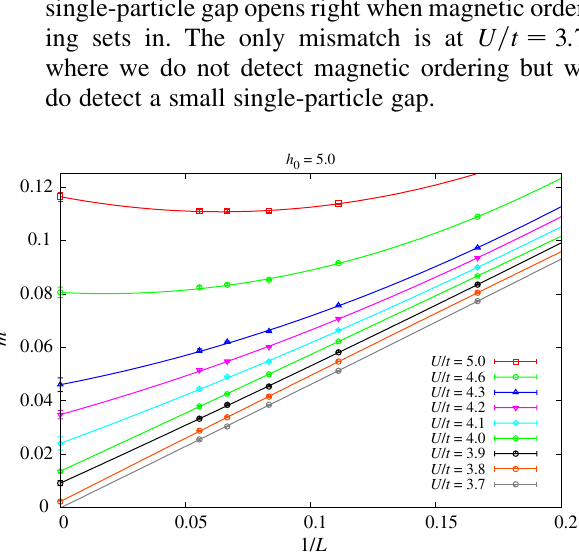
FIG. 3. Magnetic moment at pinning field h 0 ¼ 5 t as a func- tion of U=t . Here, we have used (cid:6)t ¼ 320 and (cid:2) (cid:7)t ¼ 0 : 1 . The solid lines are least-squares fits to the form a þ b=L þ c=L 2